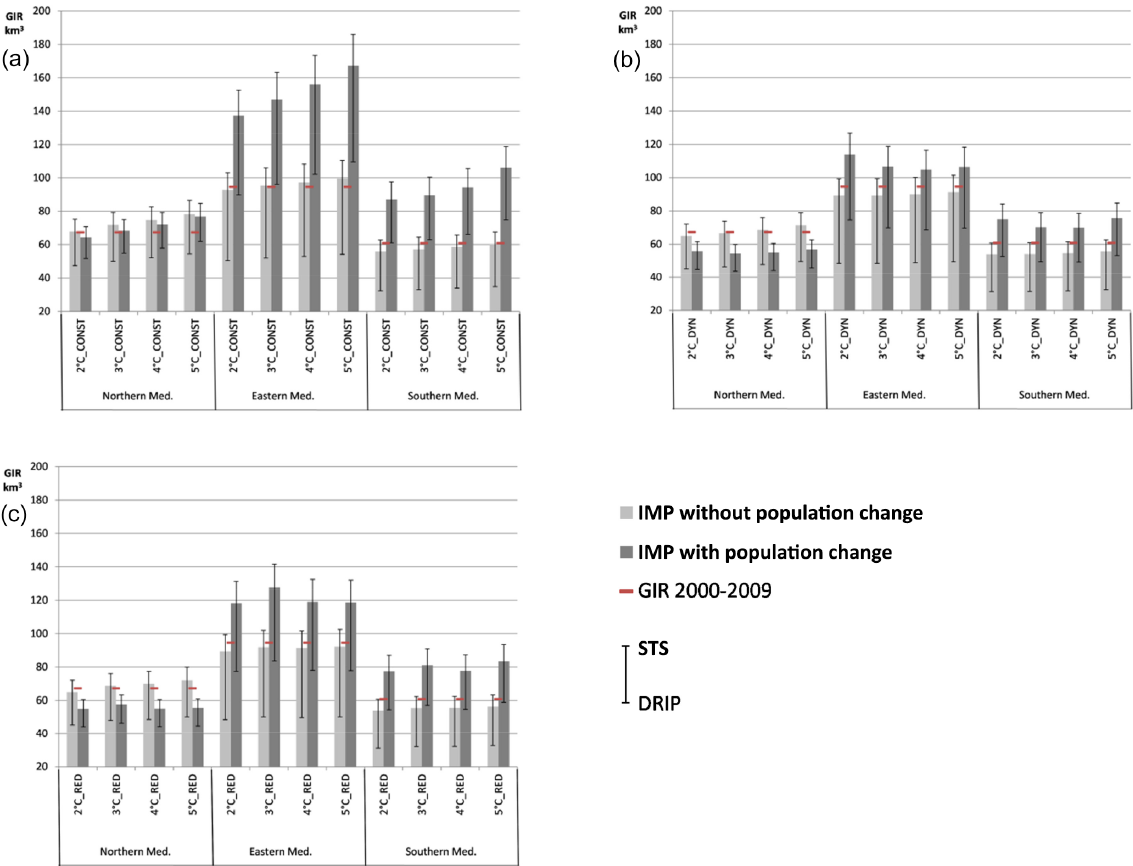
Figure 5. Regional gross irrigation water requirements (GIR) for the CONST (a) , DYN (b) and RED (c) CO 2 -fertilization scenarios, as median of 19 GCMs for the period 2080–2090, for different combinations of warming levels ( x axis), different irrigation scenarios (bars represent the IMP scenarios; whiskers represent the STS and DRIP scenario), and with or without consideration of demographic change (light grey bars: without population change; dark grey bars: with population change). Current regional gross irrigation water requirement is represented by the red lines. Note that the x axis starts at 20km 3